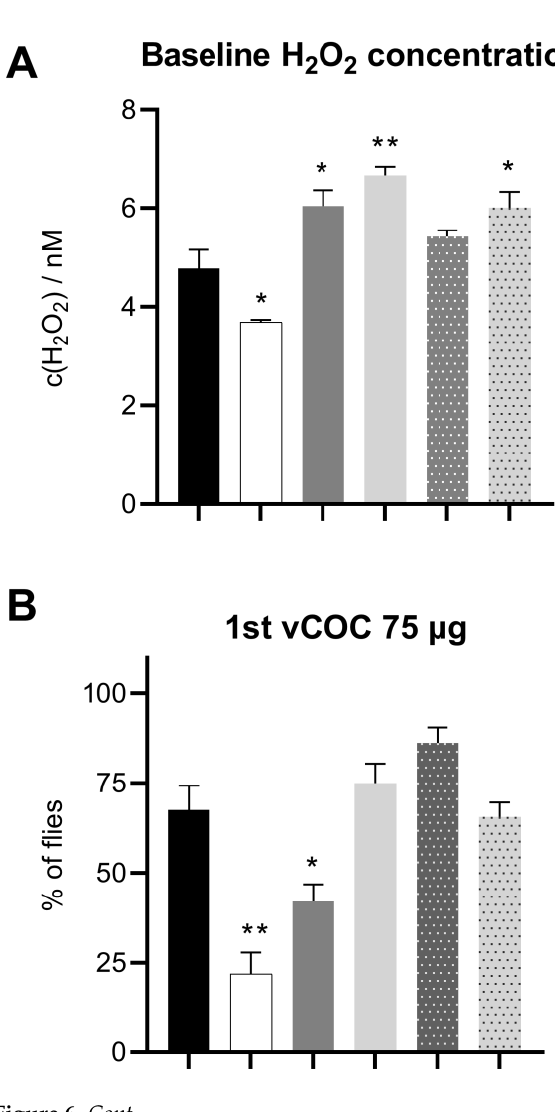
Figure 6. QUE feeding prevents development of locomotor sensitization to vCOC. wt flies without treatment (CTRL), orally fed for 24 h with 4.80 mM quercetin (QUE), 130 mM hydrogen peroxide (H 2 O 2 ), 5 mM L-3,4-dihydroxyphenylalanine (L-DA), or a combination of QUE (4.80 mM) + H 2 O 2 (130 mM) and QUE (4.80 mM) + L-DA (5 mM). ( A ) Hydrogen peroxide (H 2 O 2 ) concentration was